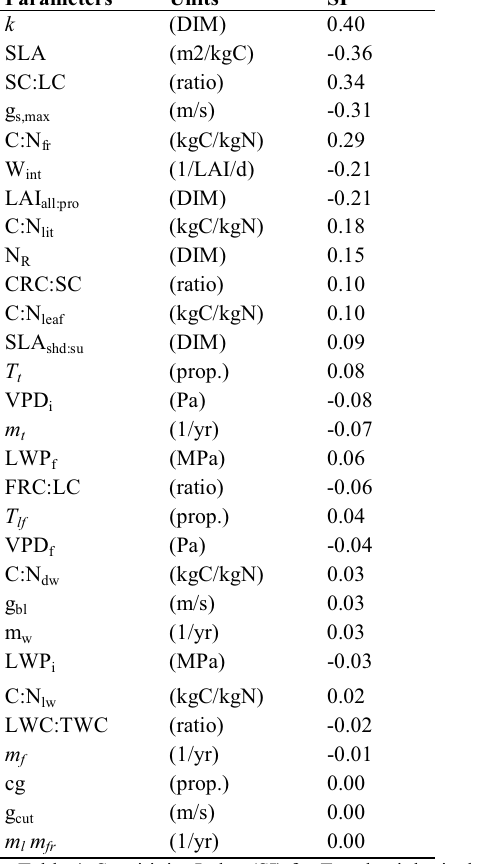
Table 4: Sensitivity Index (SI) for Ecophysiological parameters